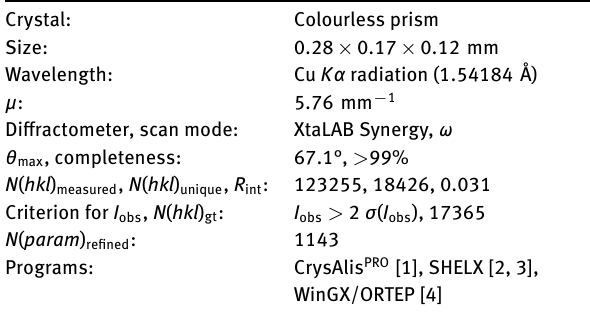
Table 1: Data collection and